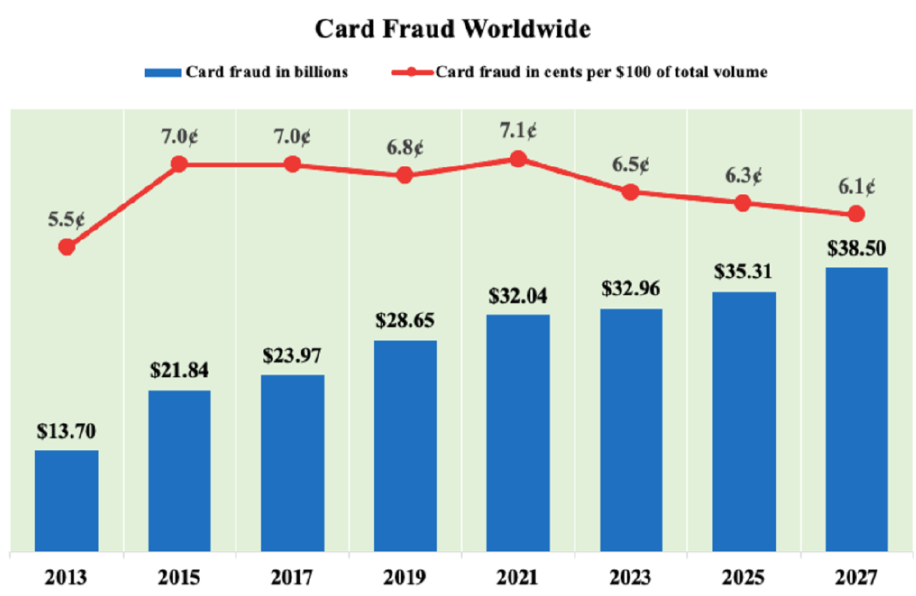
Figure 1. Card fraud worldwide from 2010 to 2027.